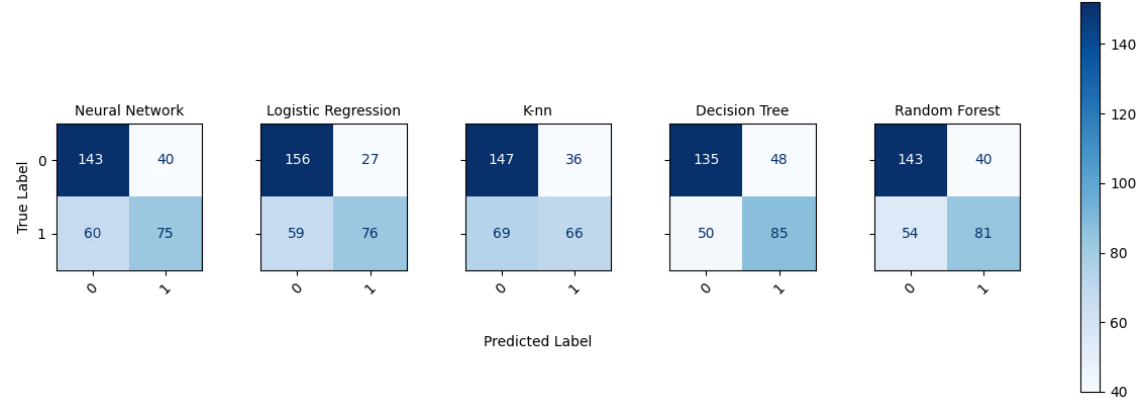
Figure 6. Confusion matrix of each implemented algorithm.